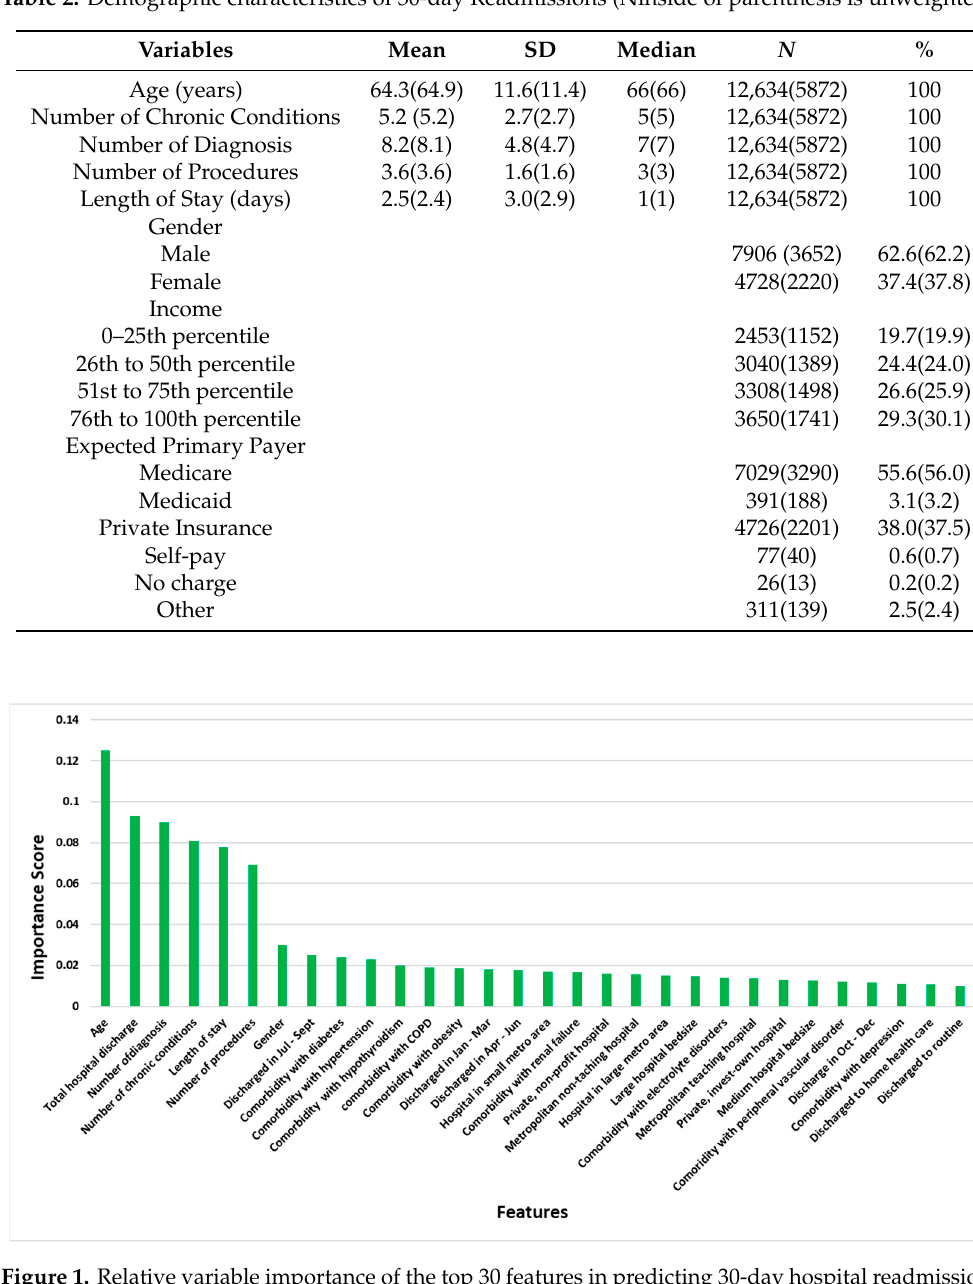
Figure 1. Relative variable importance of the top 30 features in predicting 30-day hospital readmissions in atrial fibrillation patients undergoing catheter ablation.